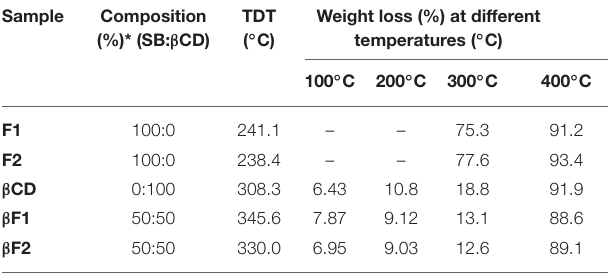
TABLE 3 | Thermal decomposition temperature